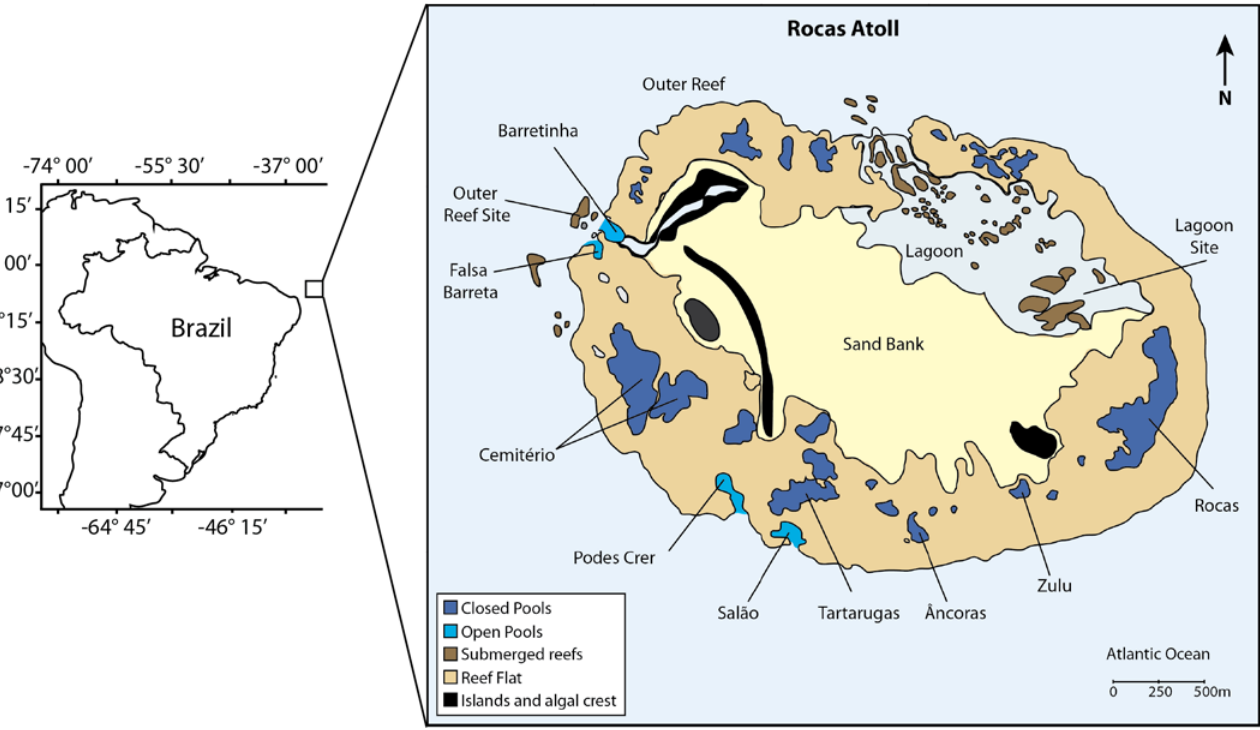
Fig 1. Studied areas at Rocas atoll, NE Brazil, indicating the different habitats. The large scale map was plotted with the R software using the 'maptools' package [41] based on data provided by the GEOphysical DAta System — Next Generation (GEODAS-NG) of the NOAA (https://www.ngdc.noaa.gov/mgg/ geodas/geodas.html). The illustration of the atoll was adapted from [39] but is not